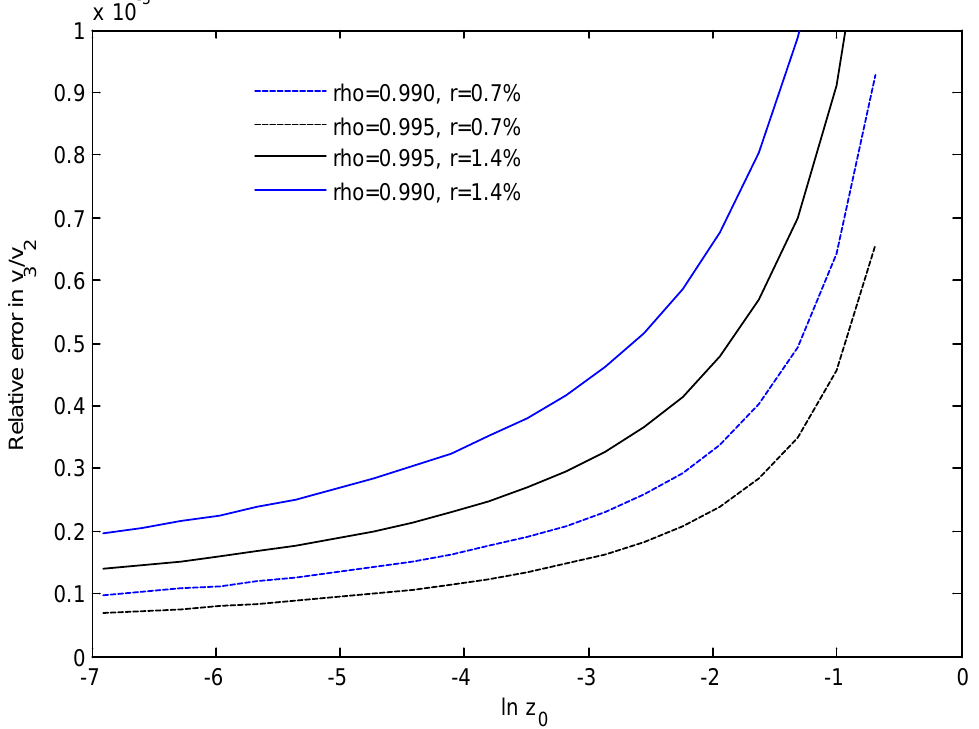
Figure 11. Relative error of the wind speed ratio γ m as a function of the logarithmic roughness